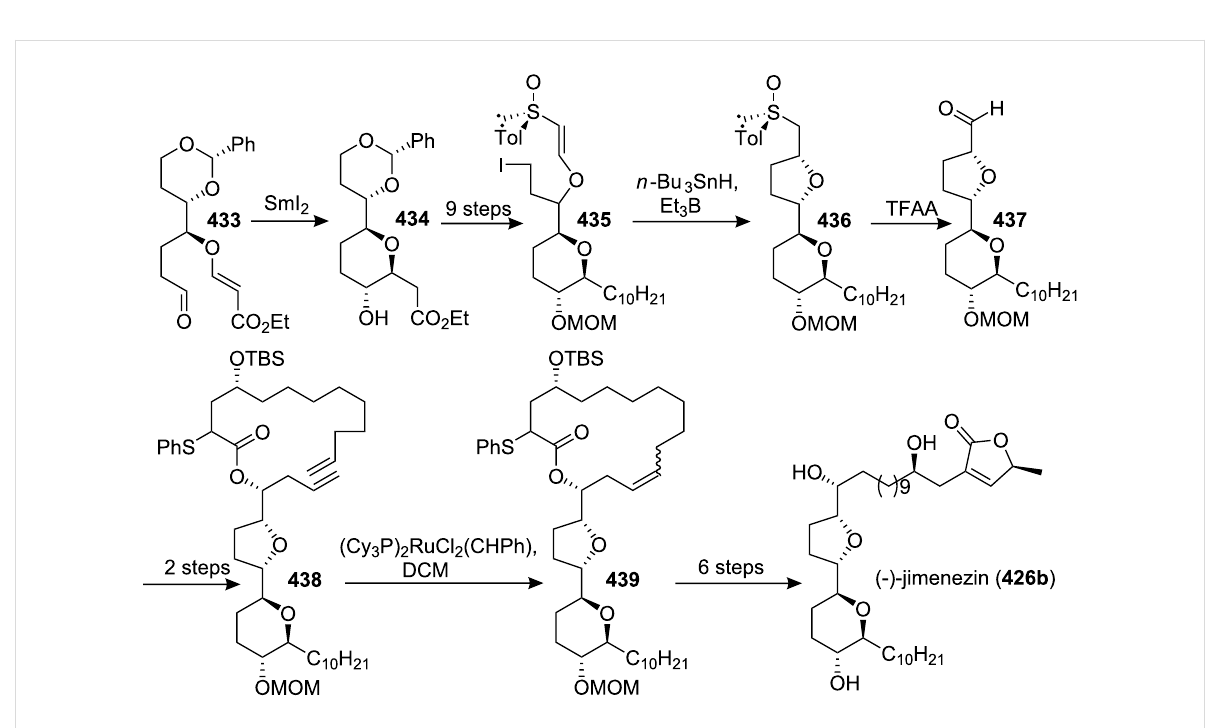
Scheme 61: Total synthesis of jimenezin by Takahashi’s group.